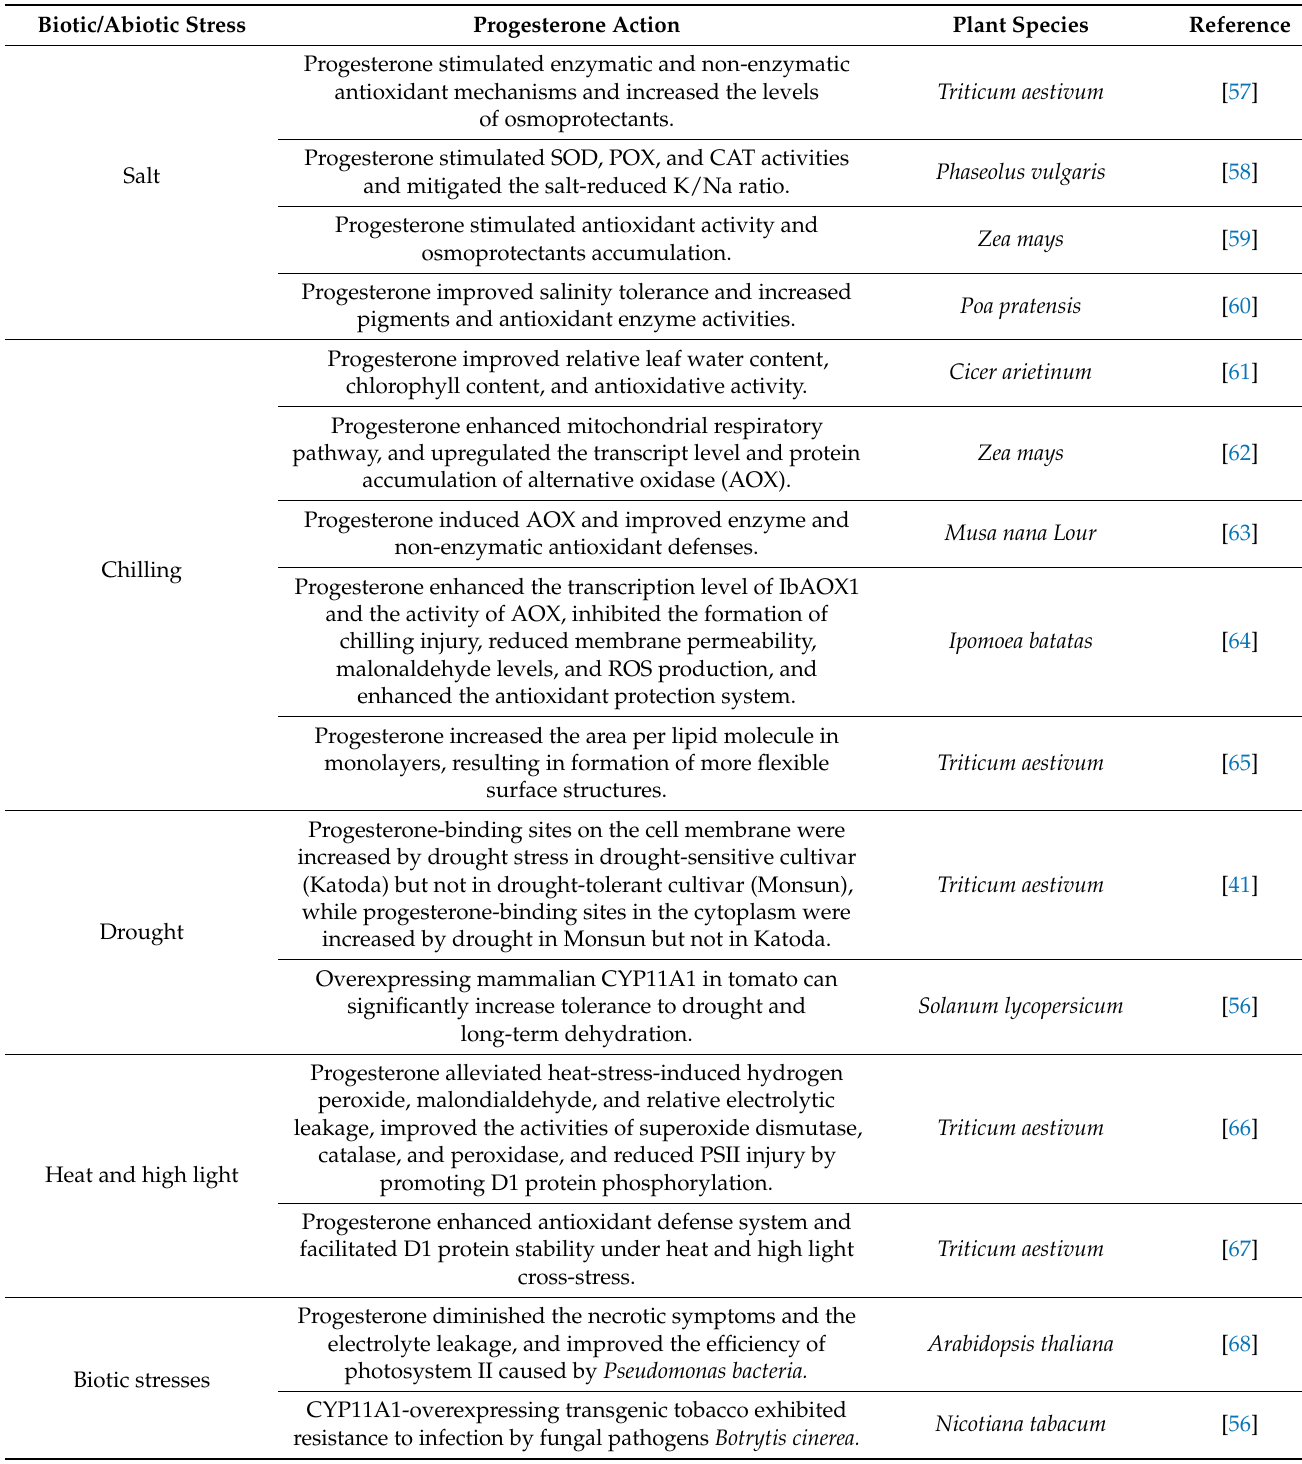
Table 2. The alleviating effects of progesterone on biotic and abiotic stresses in